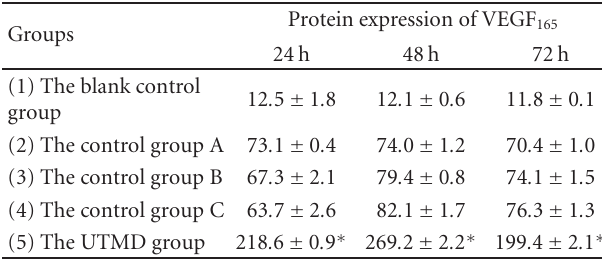
Table 1: Protein expression of VEGF 165 in mesenchymal stem cells supernatant after transfection ( n = 25,